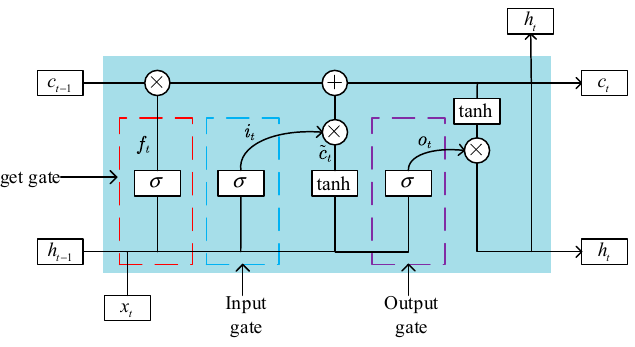
Figure 3. Internal cell states of LSTM model.